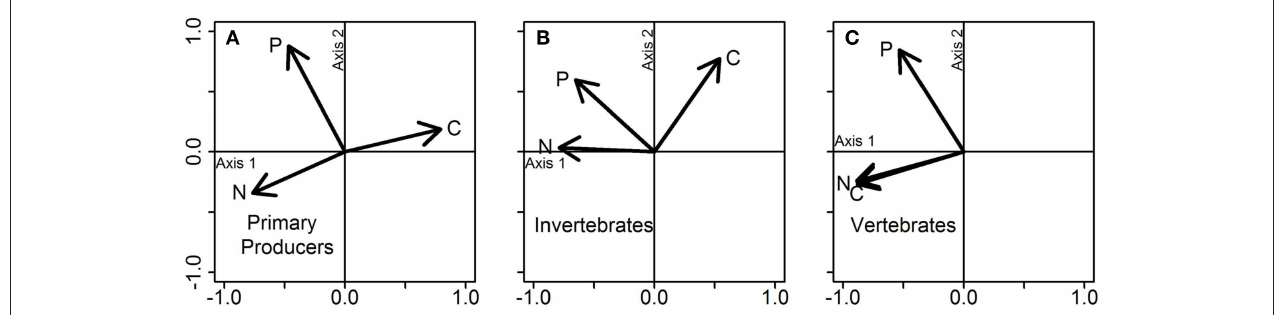
FIGURE 2 | PCA on the stoichiometric traits of (A) primary producers, (B) invertebrates, and (C) vertebrates. Each plot represents a PCA conducted separately for each group of organisms, using the data displayed jointly in Figure 1 . Vectors show the influence of the three stoichiometric traits (C, N, and P contents) on each PCA axis.